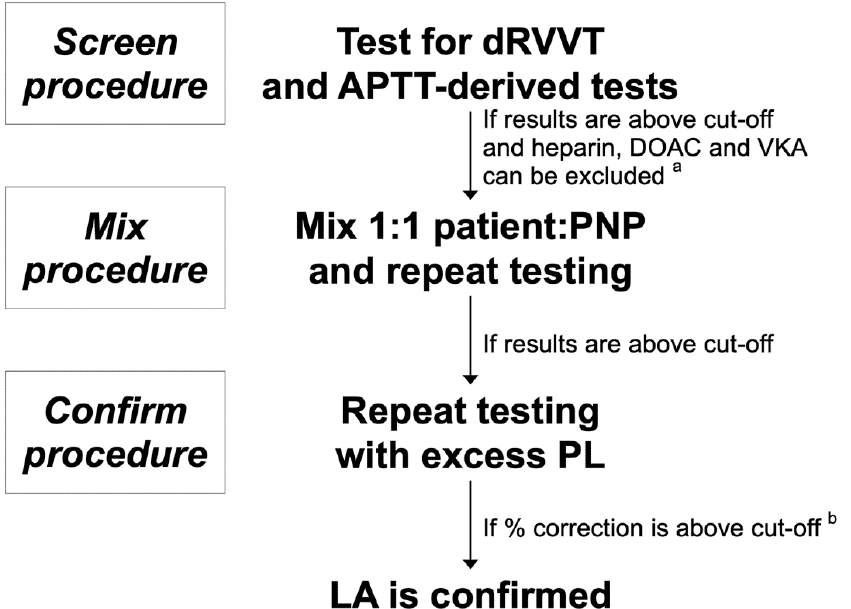
Figure 1. Three-step diagnostic procedure for LA. a Prolonged thrombin clotting time suggests the presence of unfractionated heparin; the presence of LMWH or DOAC should be confirmed by the anti-FXa or DOAC assays, respectively. b Confirmation can be performed on a mixture of patient and normal plasma if the confirm clotting time on undiluted plasma is prolonged. LA, lupus anticoagulant. dRVVT, dilute Russel viper venom test. aPTT, activated partial thromboplastin time. PNP, pooled normal plasma. PL, phospholipids. LMWH, low molecular weight heparin. DOAC, direct oral anticoagulants. VKA, vitamin K antagonists.